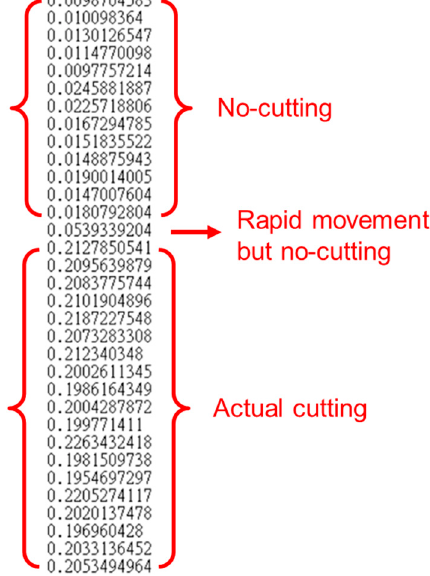
Figure 8. RMS vibration Figure 8 . RMS vibration value.